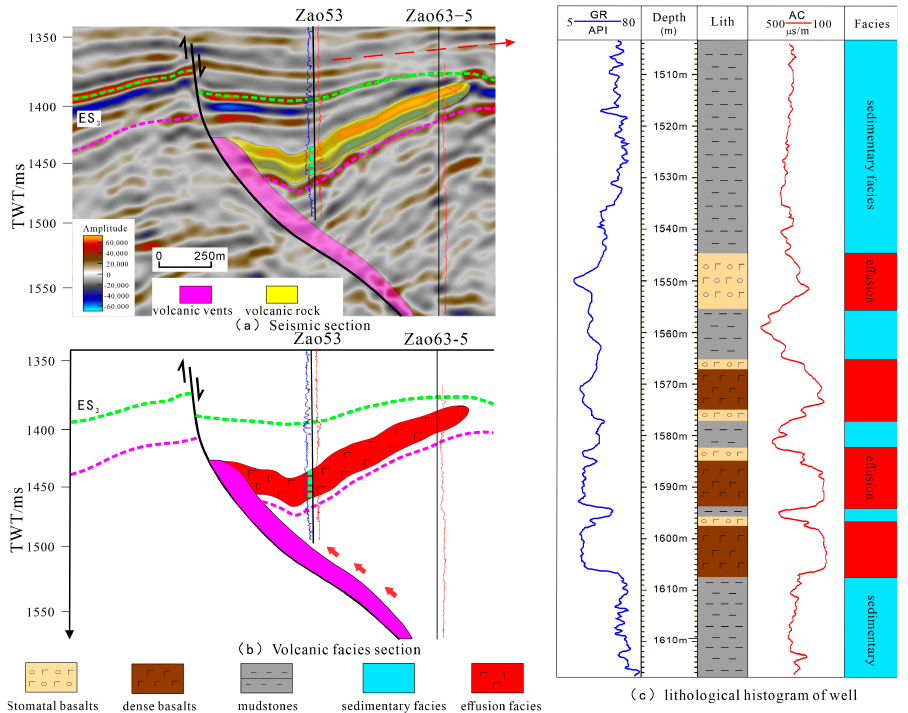
Figure 6. Sectional view of the of the fractured eruption of the Li Tianmu fault. ( a ) original seismic section; ( b ) volcanic lithofacies section; ( c ) lithological histogram of well.